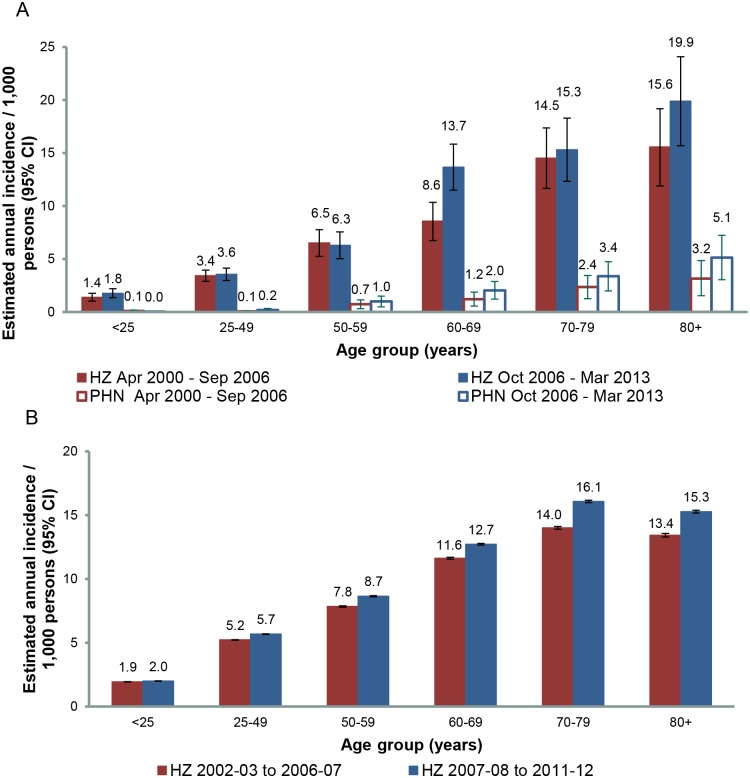
Age dependent incidence of herpes zoster and PHN over two consecutive time periods.